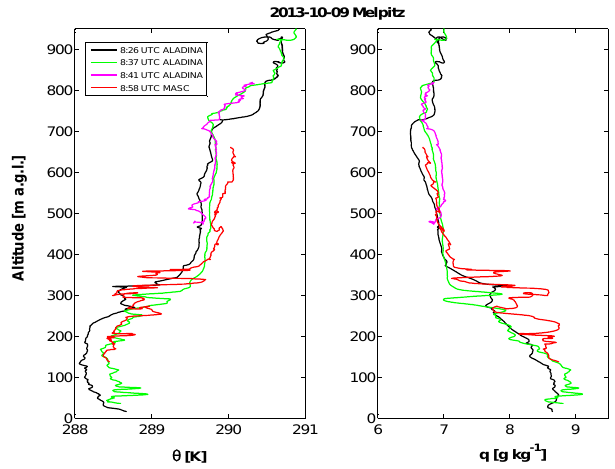
Figure 11. Vertical profiles of (a) potential temperature θ and (b) water vapour mixing ratio q measured with MASC and ALADINA in Melpitz on 9 October 2013.